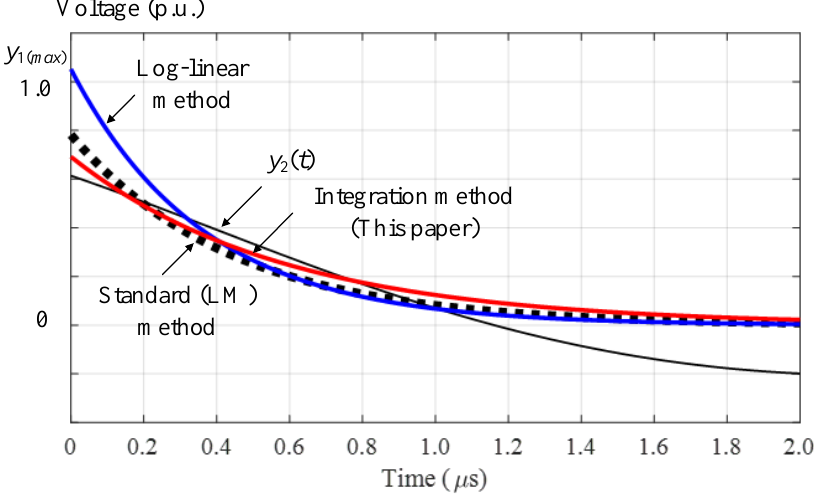
Figure 3. Comparison of the fitting curve methods (LL, LM, and